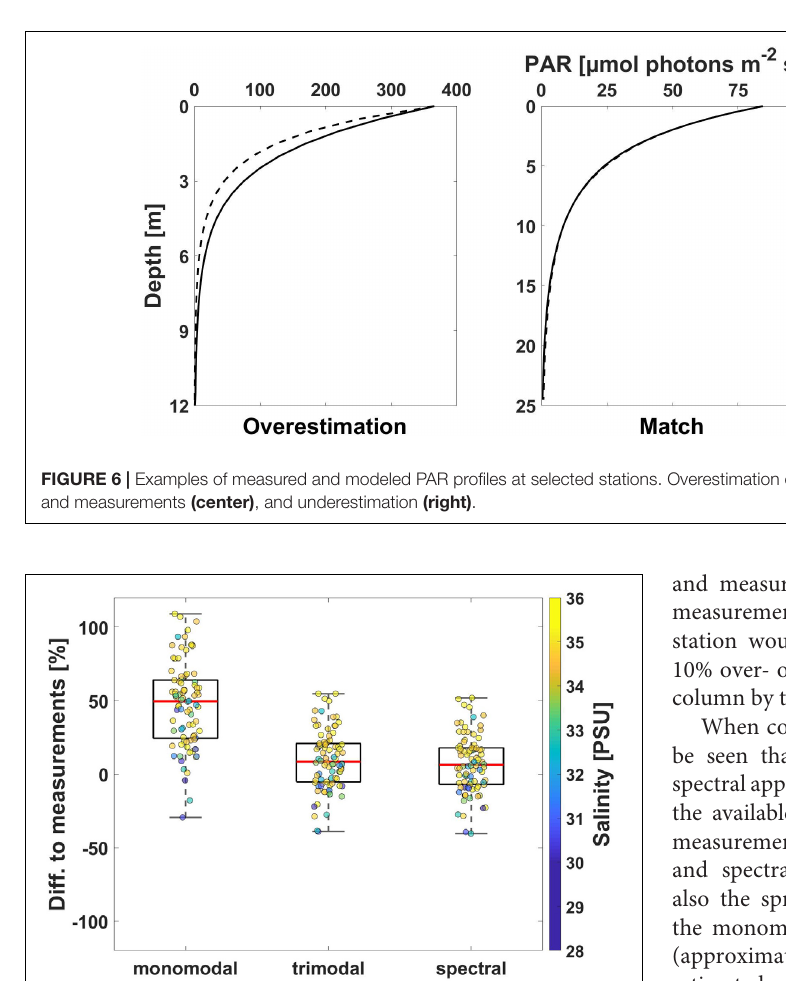
FIGURE 7 | Boxplot of the differences between depth-integrated modeled and measured PAR as percentage of the measurements. The data points give the differences for the individual stations, colored according to the respective median